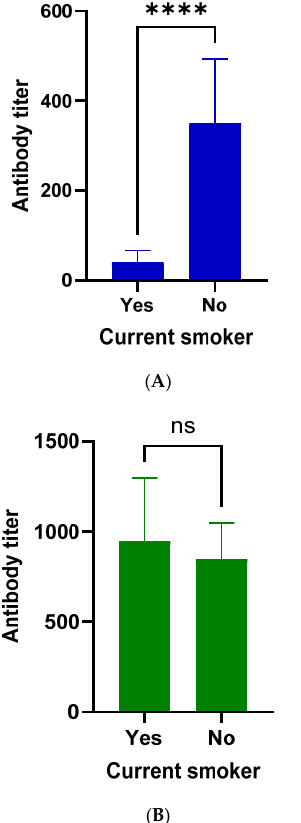
Figure A3. ( A ). Seroconversion comparison between active and former/never-smokers for lung cancer patients; mean antibody titers with 95% confidence intervals (y axis) relative to smoking status (x axis). ( B ). Seroconversion comparison between active and former/never-smokers for healthy controls; mean antibody titers with 95% confidence intervals (y axis) relative to smoking status (x axis); ns: no statistical significance; ****: statistically significant difference ( p < 0.0001)